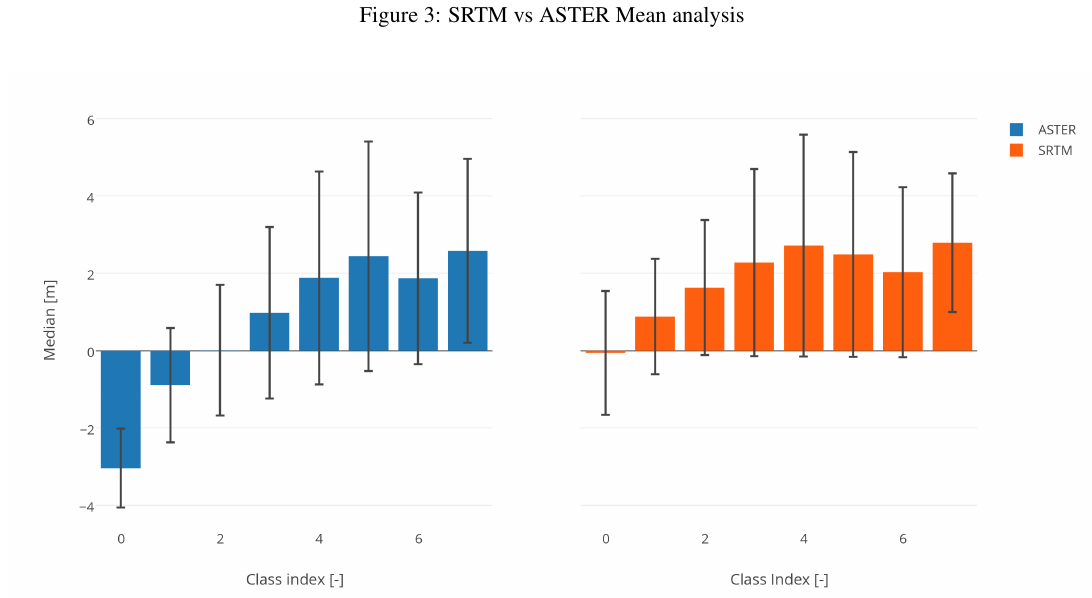
Figure 4: SRTM vs ASTER Median